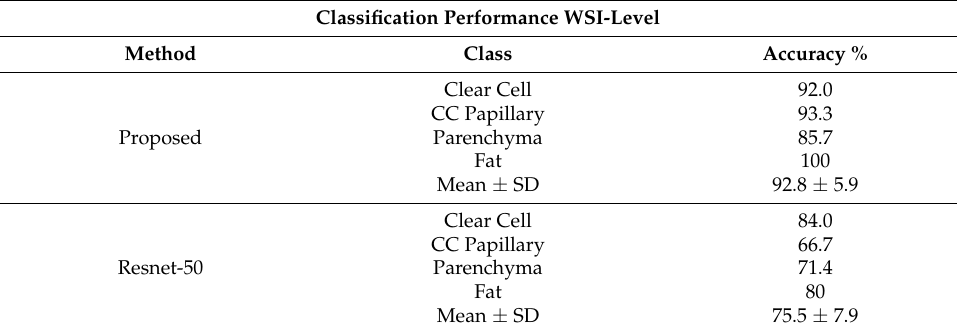
Table 7. Comparison of the classification performance on the slide